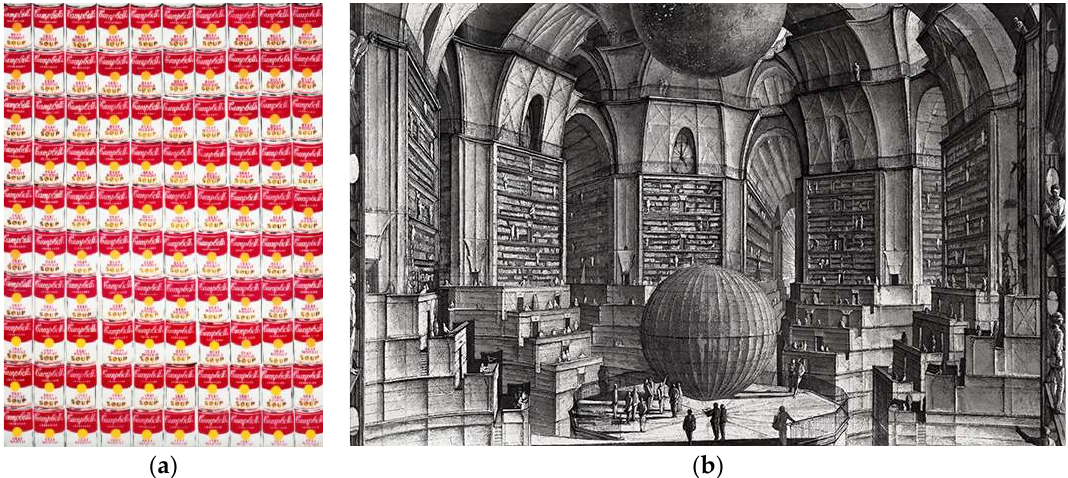
Figure 7. ( a ) Warhol, A. 100 Cans, 1962; ( b ) Desmazières, É. La Salle des planètes, En Onze